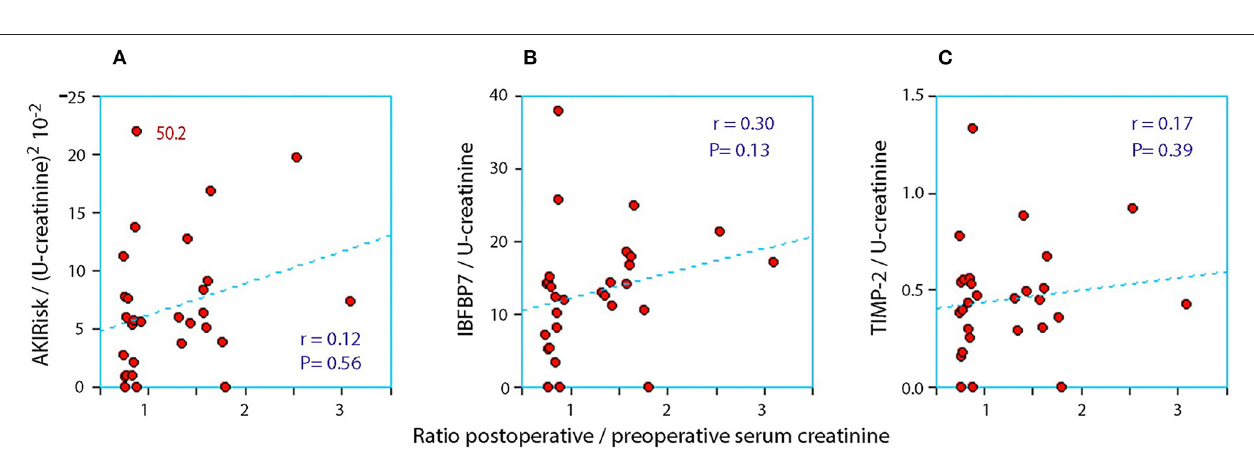
FIGURE 1 | The relationship between the perioperative relative change in serum creatinine and the postoperative urinary concentration of (A) AKIRisk TM , (B) IGFBP7, (C) TIMP-2, and (D) creatinine. No correction for sample dilution was conducted.